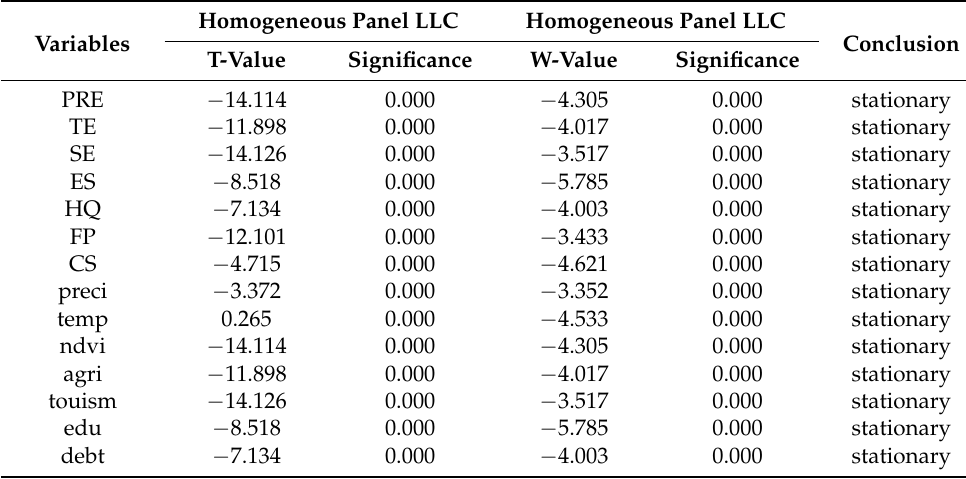
Table A1. Analysis of the stationarity of variables in the panel model.